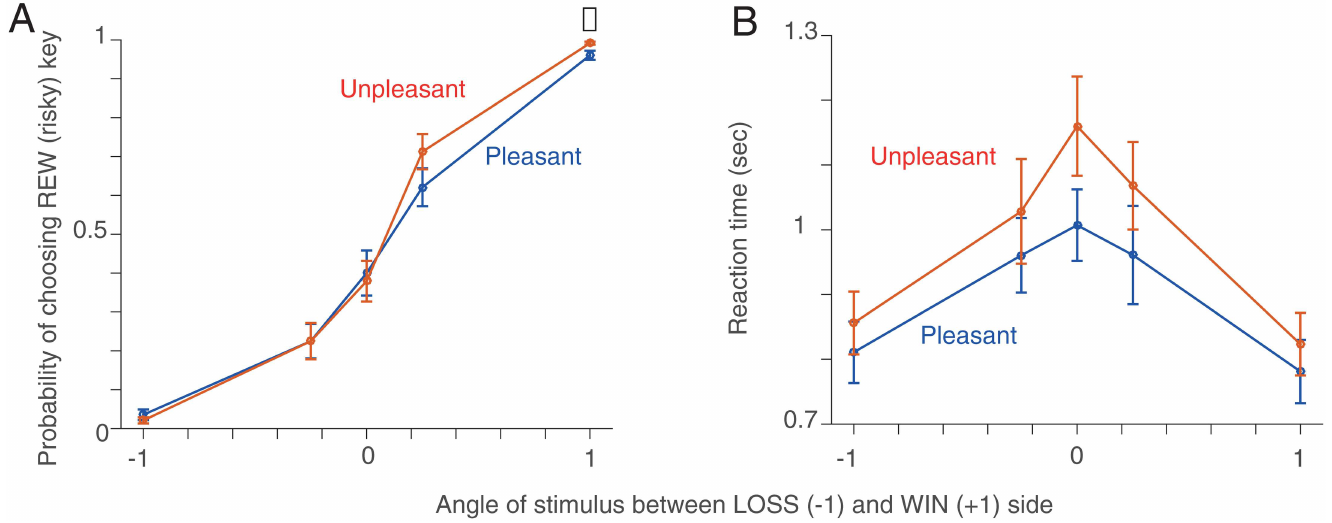
Fig 3. Model-agnostic results (Session 1). A . Probabilityof choosingthe REW (risky) key in Session 1. The red (blue) line indicates the mean and the SEM of the probability of choosingthe REW key in the Unpleasant (Pleasant) condition. When the stimulus strongly leanedtoward the WIN side ( s = 1), the difference between Pleasant and Unpleasant Room participants was mildly significant. B . Reactiontime (RT). Both groups showed significant dependence of RT on stimulus ambiguity.